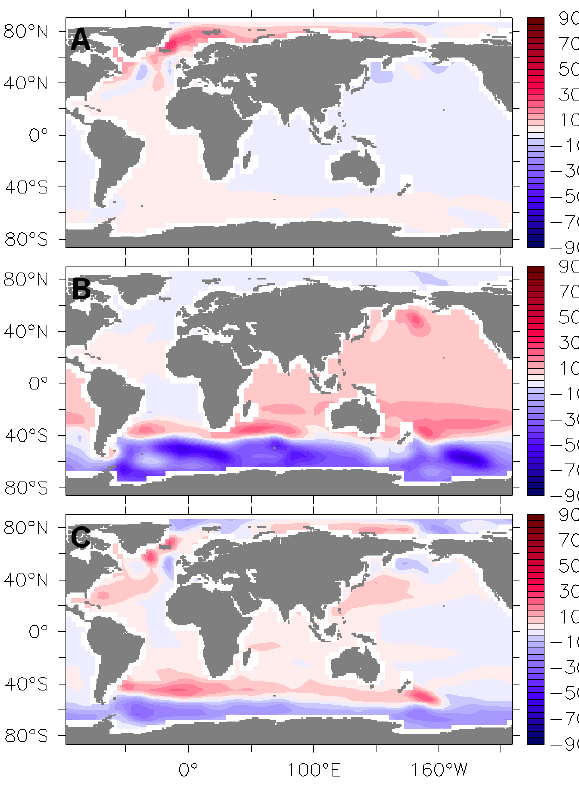
Fig. 11. Sea-level anomaly (cm) for individual forcings after 100 yr: (A) freshwater, (B) SO winds, (C) CO 2 .